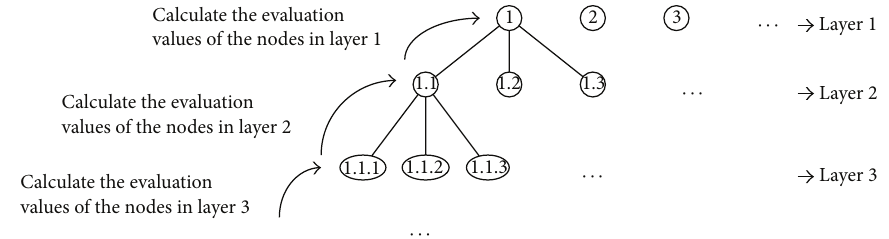
Figure 2: The illustration of the evaluation rule of